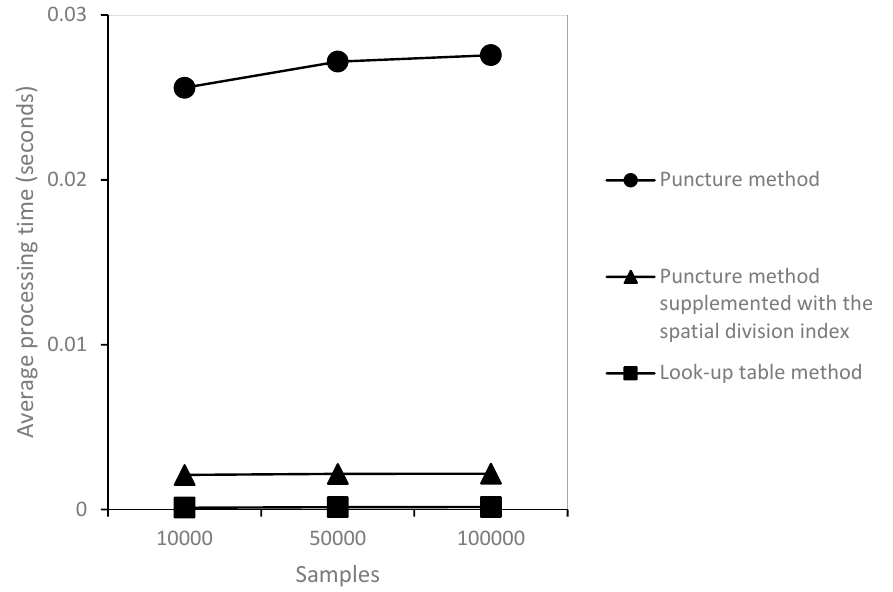
Figure 5. Performance of the vector and raster-based formats using the three different methods. Table 9. Independent samples test.